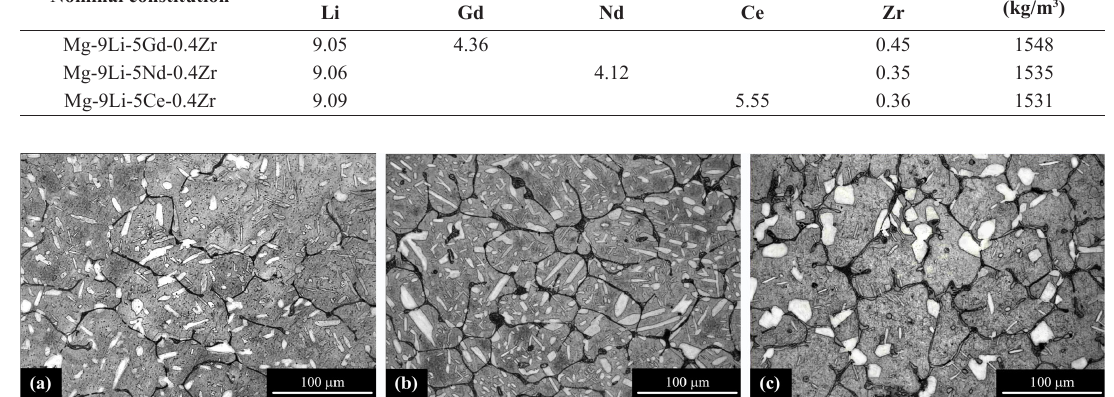
Table 1. Chemical compositions and densities of as-cast Mg-9Li-5RE-0.4Zr alloys Nominal constitution